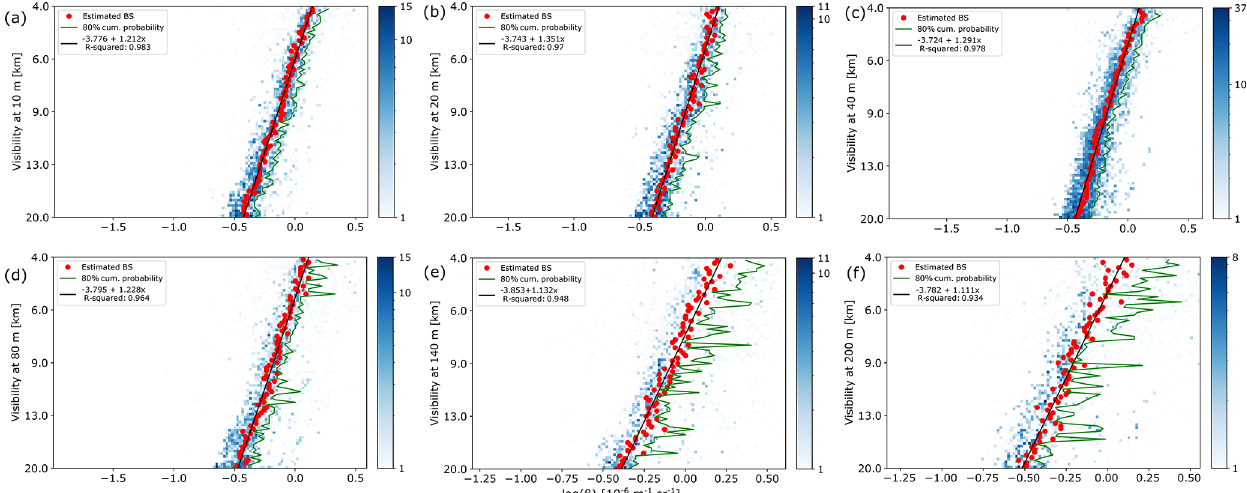
Figure 7. The 2D histograms using the maximum available range of backscatter values for various measurement heights above ground level: (a) 10, (b) 20, (c) 40, (d) 80, (e) 140 and (f) 200m above ground level. Overlain are centroid backscatter (red dots), transfer function (black) and 80% cumulative probability (green) for each